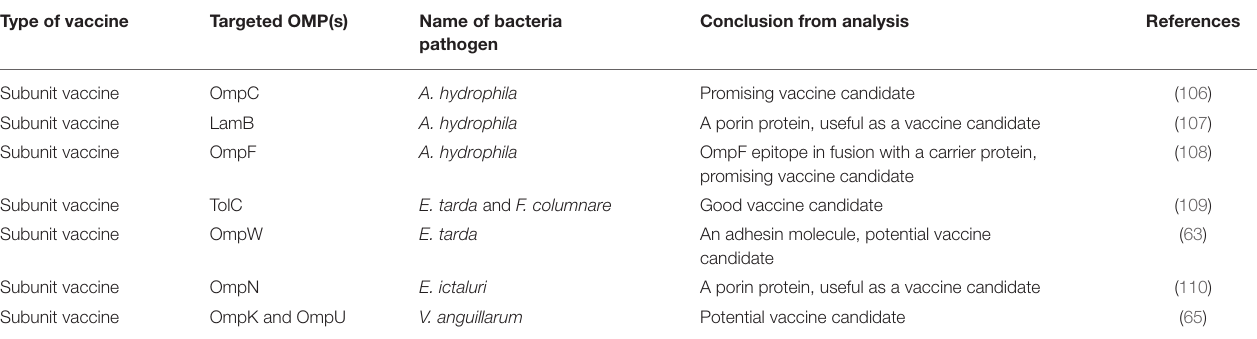
TABLE 3 | In silico vaccine designing study conducted in India to control fish